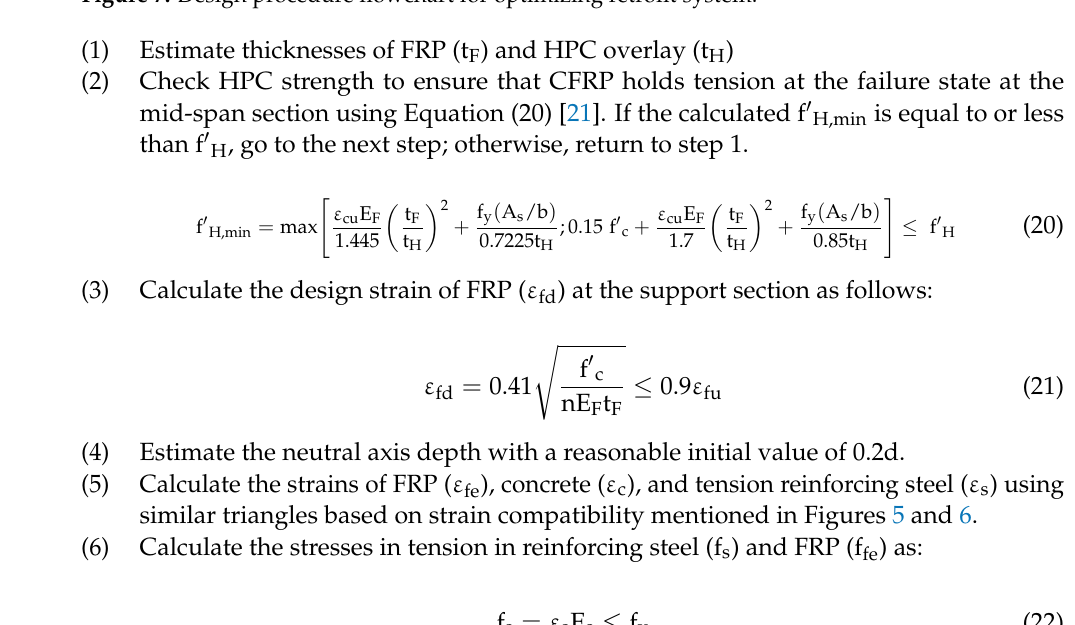
Table 2. Dimensions and material properties of the existing RC slab.